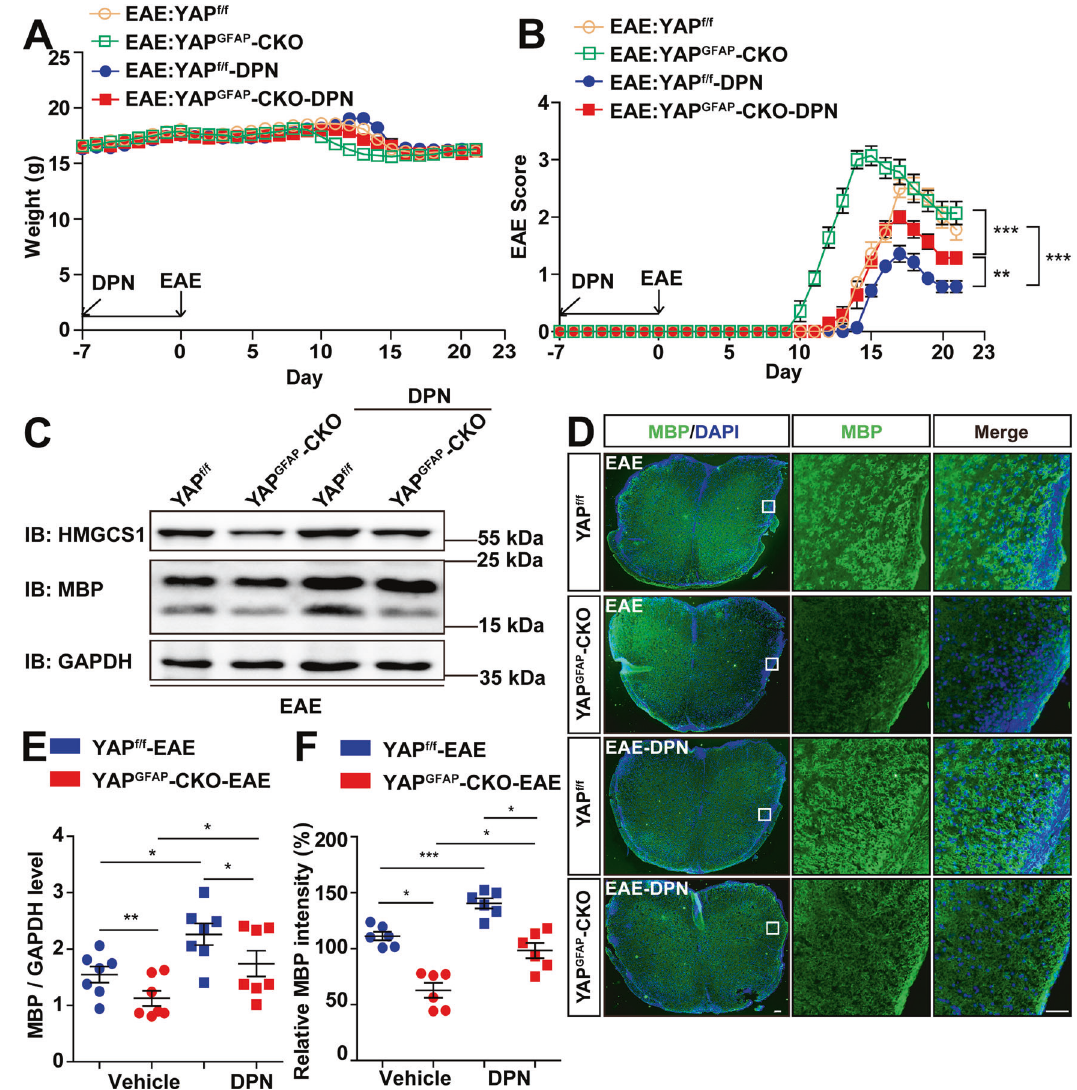
Fig. 6 Upregulating cholesterol-synthesis pathways partially rescued the demyelination de fi cits in YAP GFAP -CKO EAE mice. A The body weight of YAP f/f and YAP GFAP -CKO mice treated with vehicle or DPN from 0 to 21 dpi during the EAE modeling process ( n = 7). B The EAE score of YAP f/f and YAP GFAP -CKO mice treated with vehicle or DPN from 0 to 21 dpi during the EAE modeling process ( n = 7). C Western blot showed the HMGCS1 and MBP expression in the lumbar spinal cords of YAP f/f and YAP GFAP -CKO EAE mice treated with vehicle or DPN. D Immunostaining of MBP (green) in the lumbar spinal cords of YAP f/f and YAP GFAP -CKO EAE mice treated with vehicle or DPN. E Quanti fi cation of the MBP level as shown in C ( n = 7, normalized to GAPDH). F Quanti fi cation of the relative intensity of MBP as shown in D (normalized to YAP f/f EAE group, n = 6). Scale bars, 50 μ m. Data were mean ± SEM. Two-way ANOVA with Bonferroni ’ s post-tests, * p < 0.05, ** p < 0.01, *** p <